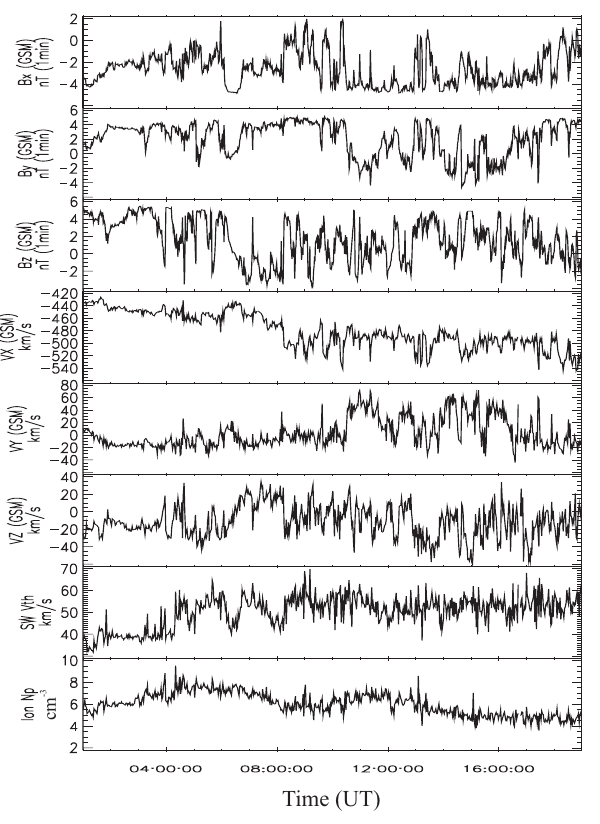
Fig. 2. ACE magnetic field, number density, proton temperature and velocity parameters for 7 June